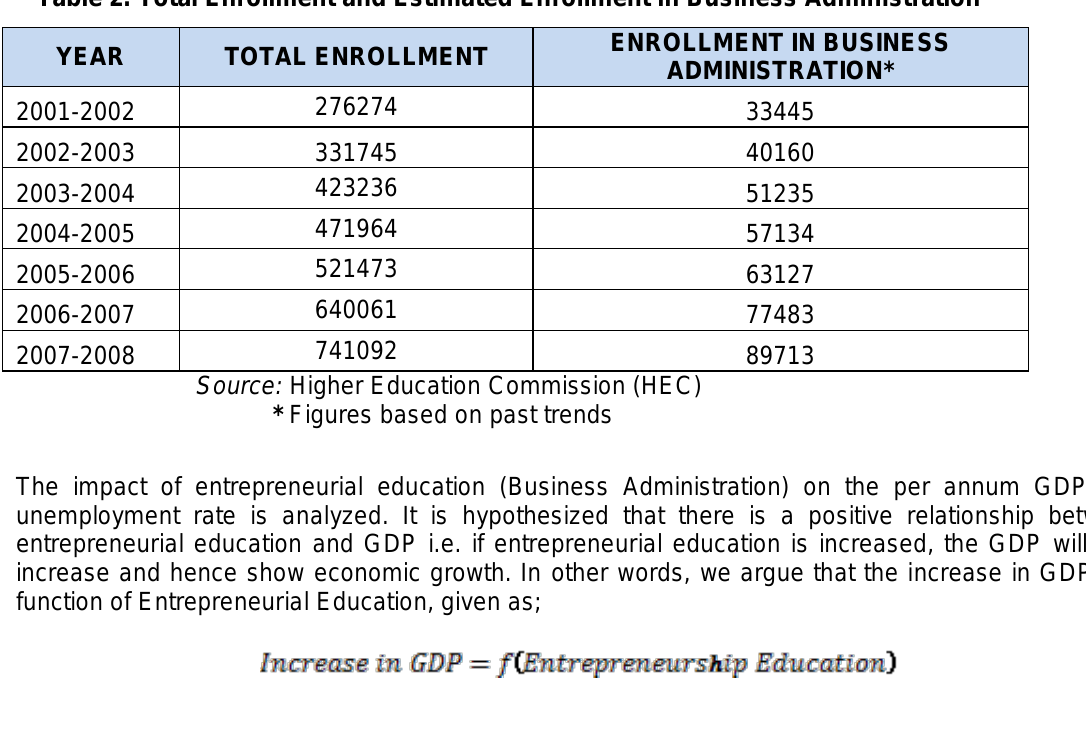
Table 2: Total Enrollment and Estimated Enrollment in Business